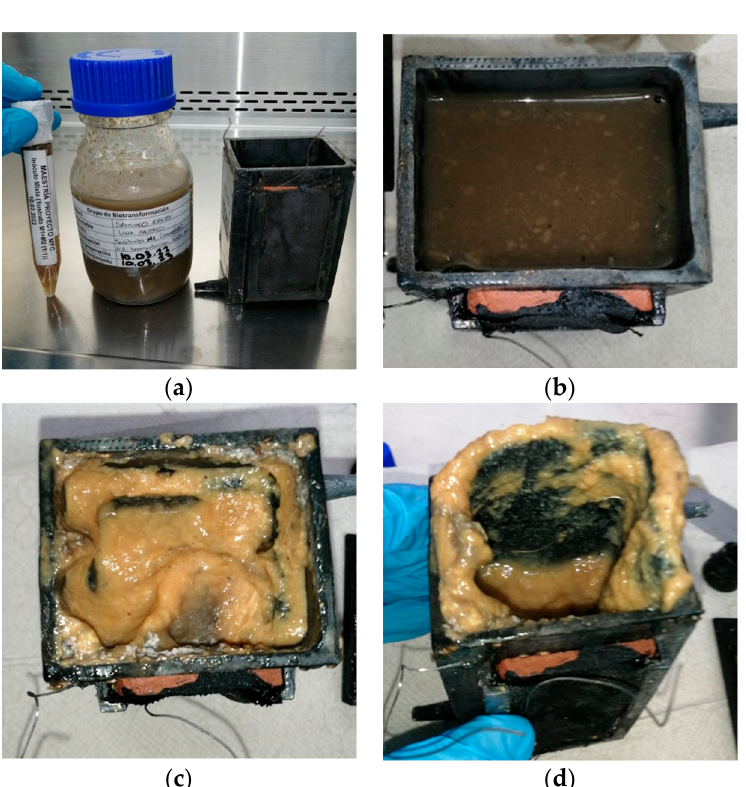
Figure A1. Photographs of the interior of the MFC: ( a ) and ( b ) initial or day 0, ( c ) final OC day 21, and ( d ) final CC day